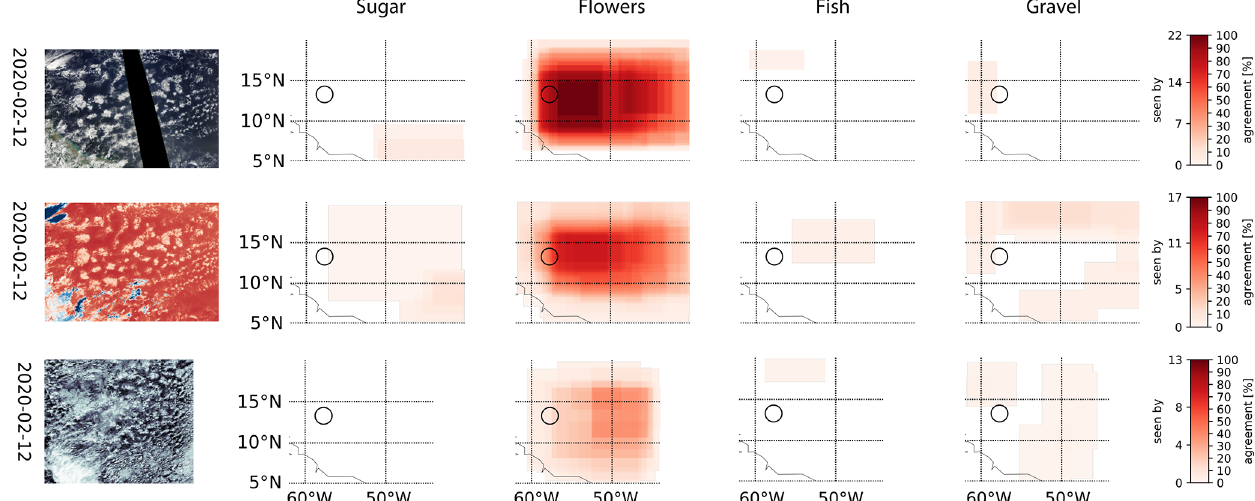
Figure 4. Manual-classification examples for the three workflows (top to bottom: visible, infrared and simulation). The labels for each pattern (from left to right: sugar, flowers, fish and gravel) are shown next to the labeled image. Coastline of South America is marked in black. The circle marks the EUREC 4 A circle, one focus area of the EUREC 4 A field campaign and the main flight pattern of the participating research aircraft HALO (High Altitude and LOng Range Research Aircraft) (Konow et al., 2021). Coastlines are based on GSHHG (Global Self-consistent, Hierarchical, High-resolution Shorelines) shapefiles (Wessel and Smith, 1996). Please note that the date format in this figure is